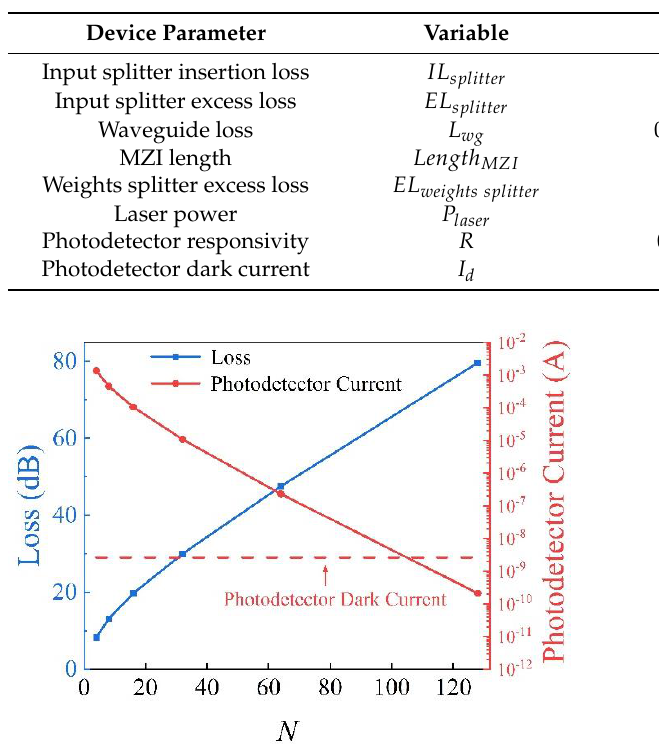
Table 2. Device parameters used for loss analysis of the PCNN chip.